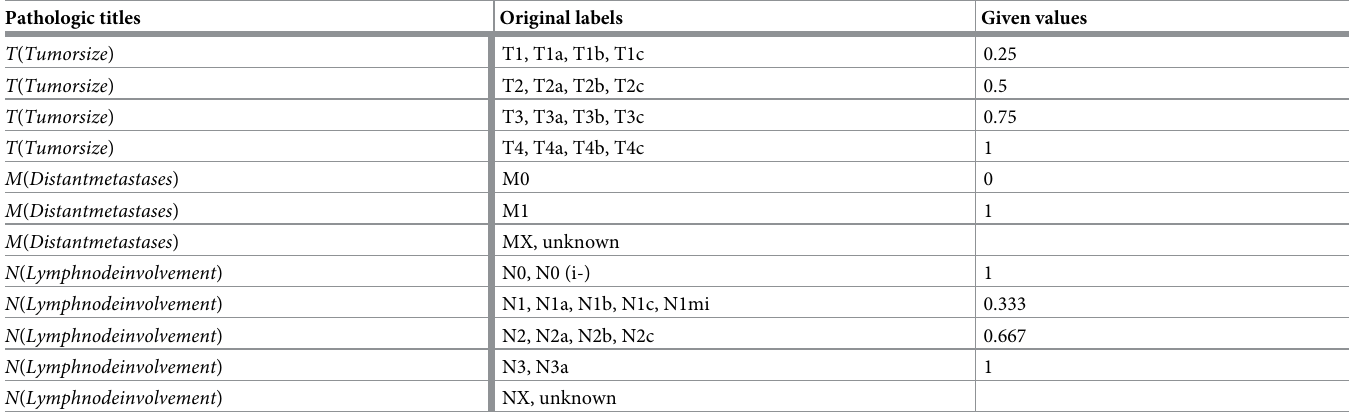
Table 2. The discrete value table of TCGA clinical